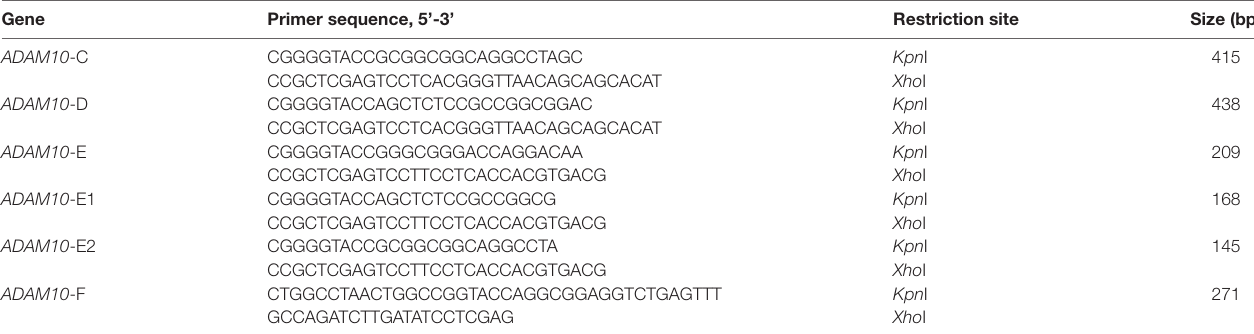
TABLE 1 | Primer sequences for ADAM10